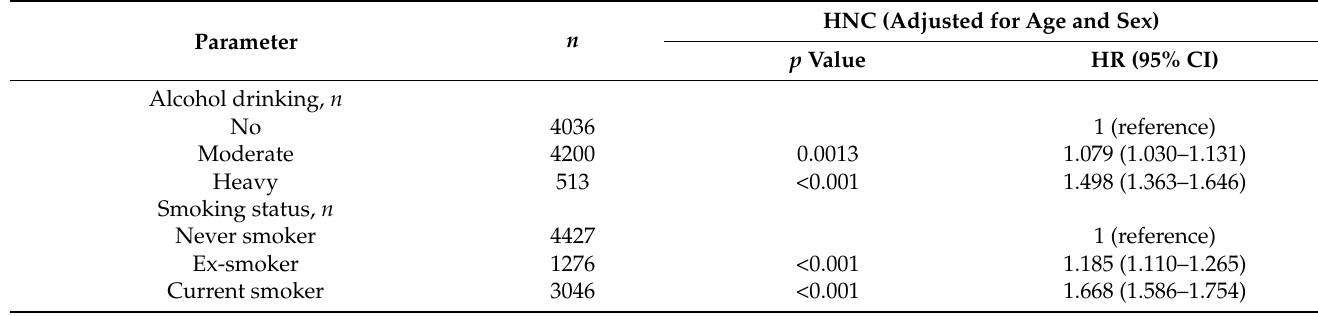
Table 2. Hazard ratio of head and neck cancer risk according to each